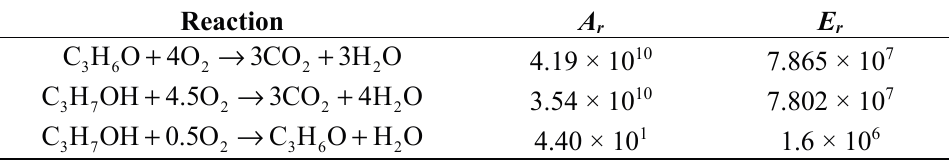
Table 3. Chemical kinetic parameters for heterogeneous surface reaction of acetone and 2-propanol.